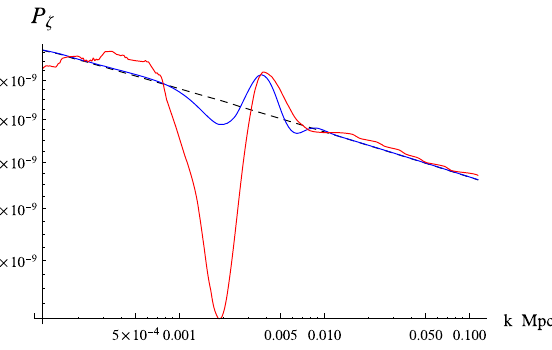
k 0 = 1 . 13 × 10 − 3 ( blue ). On the left , the red lines correspond to the best-fit reconstructed primordial power spectrum from Ref. [16]. The dashed lines correspond to the featureless spectrum